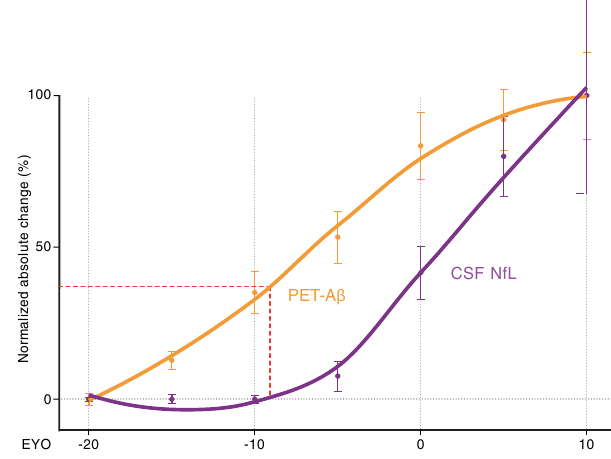
Fig. 5 | Trajectories ofbrain A β deposition and CSF NfL in familial Alzheimer´s disease. Normalized absolute changes (%) in brain A β -PET (using Pittsburgh Compound B;orange)and CSFNfL (purple)asa function of the estimatedyears to clinical symptom onset (EYO). To generate the curves, cross-sectional data from previous Dominantly Inherited Alzheimer ’ s Network (DIAN) publications were used (for A β -PET 28 ; for CSF NfL 27 ).For better comparison of biomarker trajectories between familial ADand the APPPS1 mouse model (seeFig.1), A β -PET and CSFNfL (between EYO − 20 and 10) were binned in increments of 5 years ( n =29, 29, 26, 31, 45, and 19 for − 20to − 15, − 15 to − 10, − 10 to − 5, − 5 to 0,0 to 5,5 to10,respectively, forA β -PET; n =8,15,13,18,17,and8for − 20to − 15, − 15to − 10, − 10to − 5, − 5to0,0to 5, 5 to 10, respectively, for CSF NfL). The relative percent change across EYO for each biomarker was calculated, and locally weighted estimated scatter plot smoothing(LOESS)wasusedforillustrations.Mean±s.e.mfornormalizedabsolute change of biomarker within each EYO bin are displayed. As in the mouse studies, the increase of CSF NfL in mutation carriers is plotted as the increase over that of non-mutation carriers, i.e., the mean NfL values of non-carrier patients were sub- tracted from those of the mutation carriers within each EYO bin. Of note, CSF NfL started to increase around EYO − 10 when A β -PET reached less than half-maximal changes (red dotted line). These curves are based on cross-sectional data; if long- itudinal data are used, both curves shift to lower EYO to similar degrees 27,70